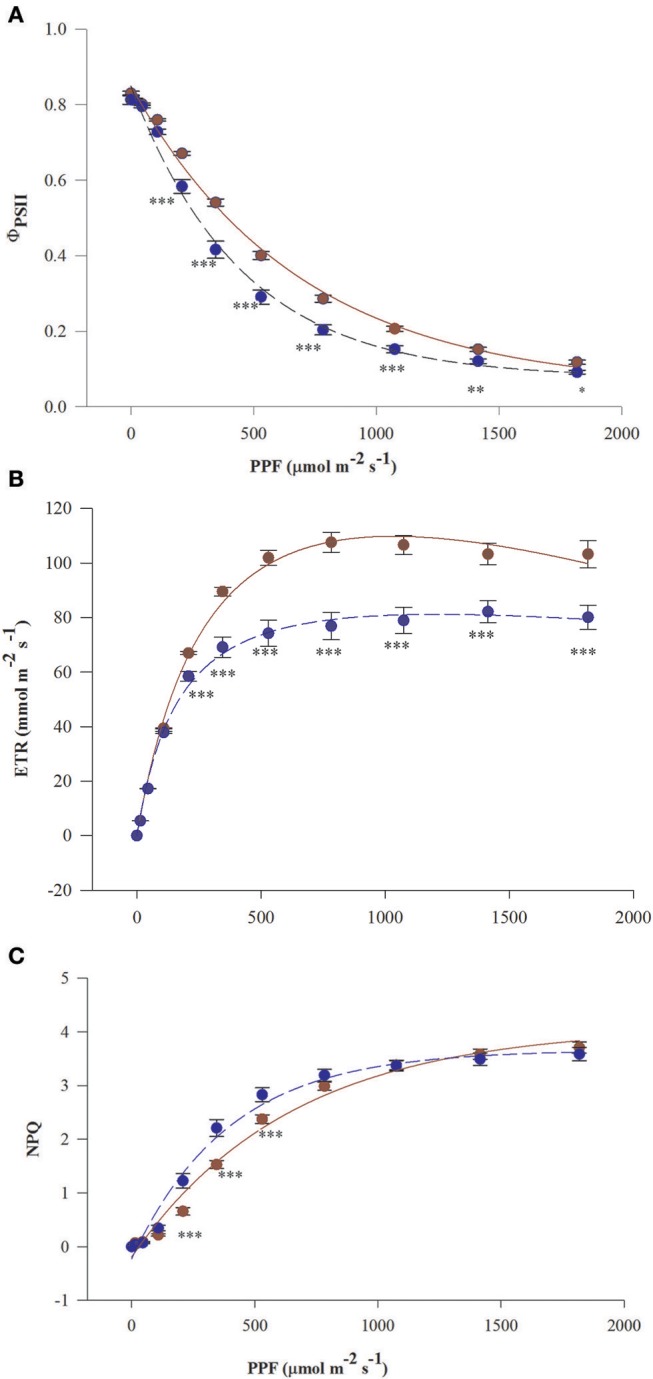
Light response curves of needles of T. baccata individuals growing with (brown solid line) or without fertilization (dark blue dotted line): (A) Photosystem II (PSII) quantum yield (ΦPSII), (B) Apparent electron transfer rate (ETR), and (C) Non-photochemical quenching of fluorescence (NPQ) vs. photosynthetic photon flux (PPF). The fluorescence measurements were conducted in June 2015. The equation used for non-linear fitting together were as follows: (A)
ΦPPFsat =m+ae-bPPFsat+ce-dPPFsat, (B)
ETR=α1-βPPF1+γPPFPPF,
(C) NPQ = m+a(1−e(−bPPF)). The values of adjusted coefficients of determination and probability were described by Radj2 ≥ 0.98 with P < 0.001 for all used equations. Data are means with standard errors (SE, n = 12). Asterisks indicate statistical differences between means at *0.05 > P ≥ 0.01, **0.01 > P ≥ 0.001, P < 0.001***.